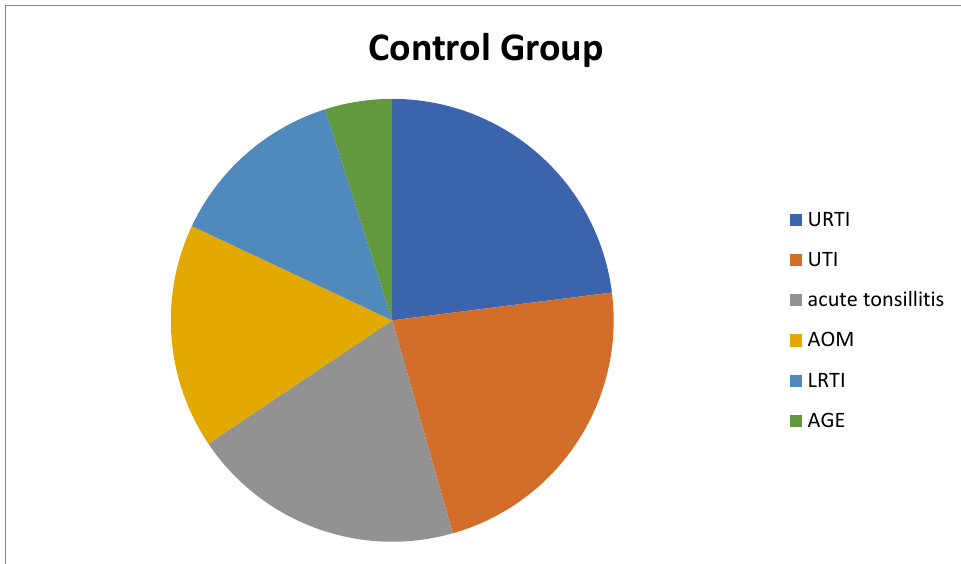
Figure 1. Diagnoses of patients in the study group that cause fever. LRTI: Lower Respiratory Tract Infection, URTI: Upper Respiratory Tract Infection, AOM: Acute Otitis Media, UTI: Urinary Tract Infection, AGE: Acute Gastroenteritis.